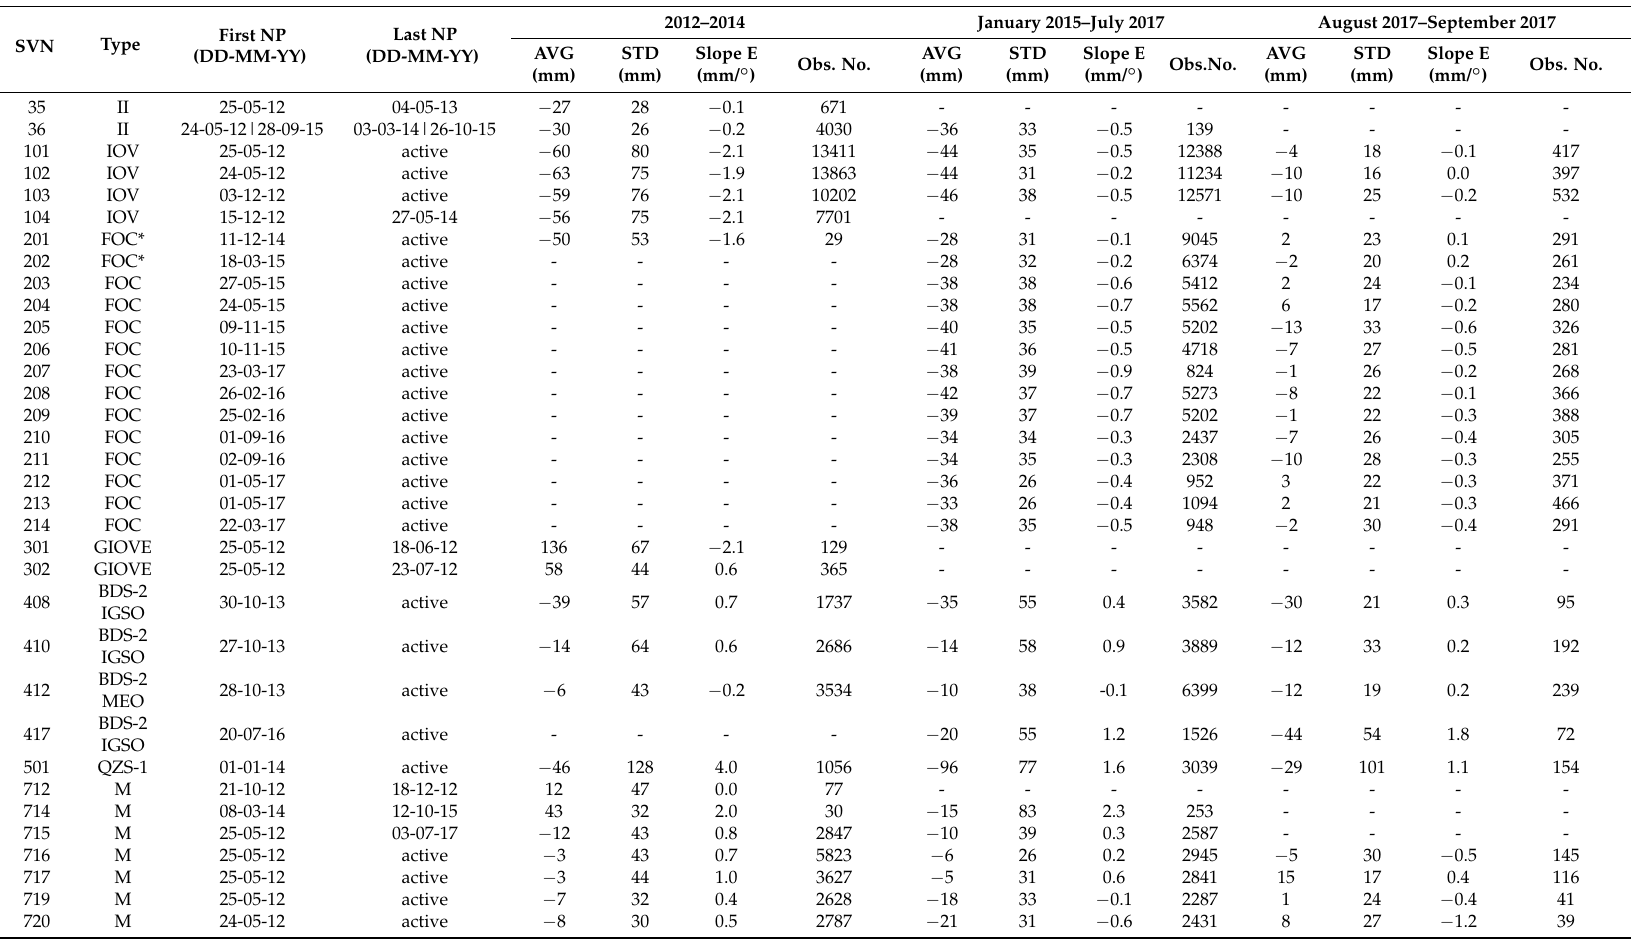
Table A2. SLR residual statistics of CODE’s MGEX orbit in next periods since the beginning of CODE’s MGEX orbits. Abbreviations used: First NP, date of first registered normal point; Last NP, date of last registered normal point; AVG, average (mm); STD, standard deviation (mm); Slope E, regression slope of SLR residuals as a function of elevation angle (mm/ ◦ ); Obs. No., number of